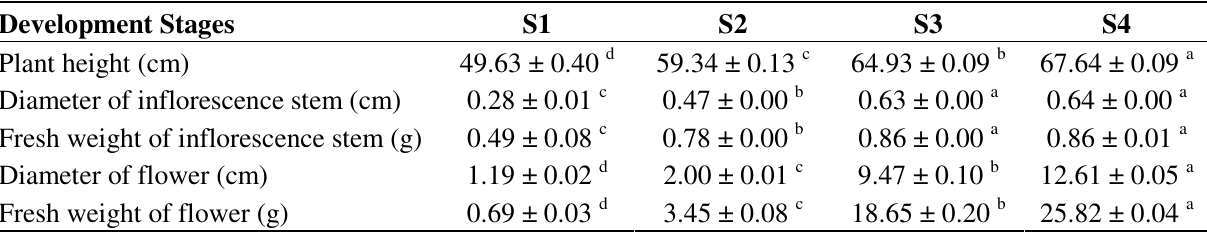
Table 1. Morphological indices of development Paeonia lactiflora .